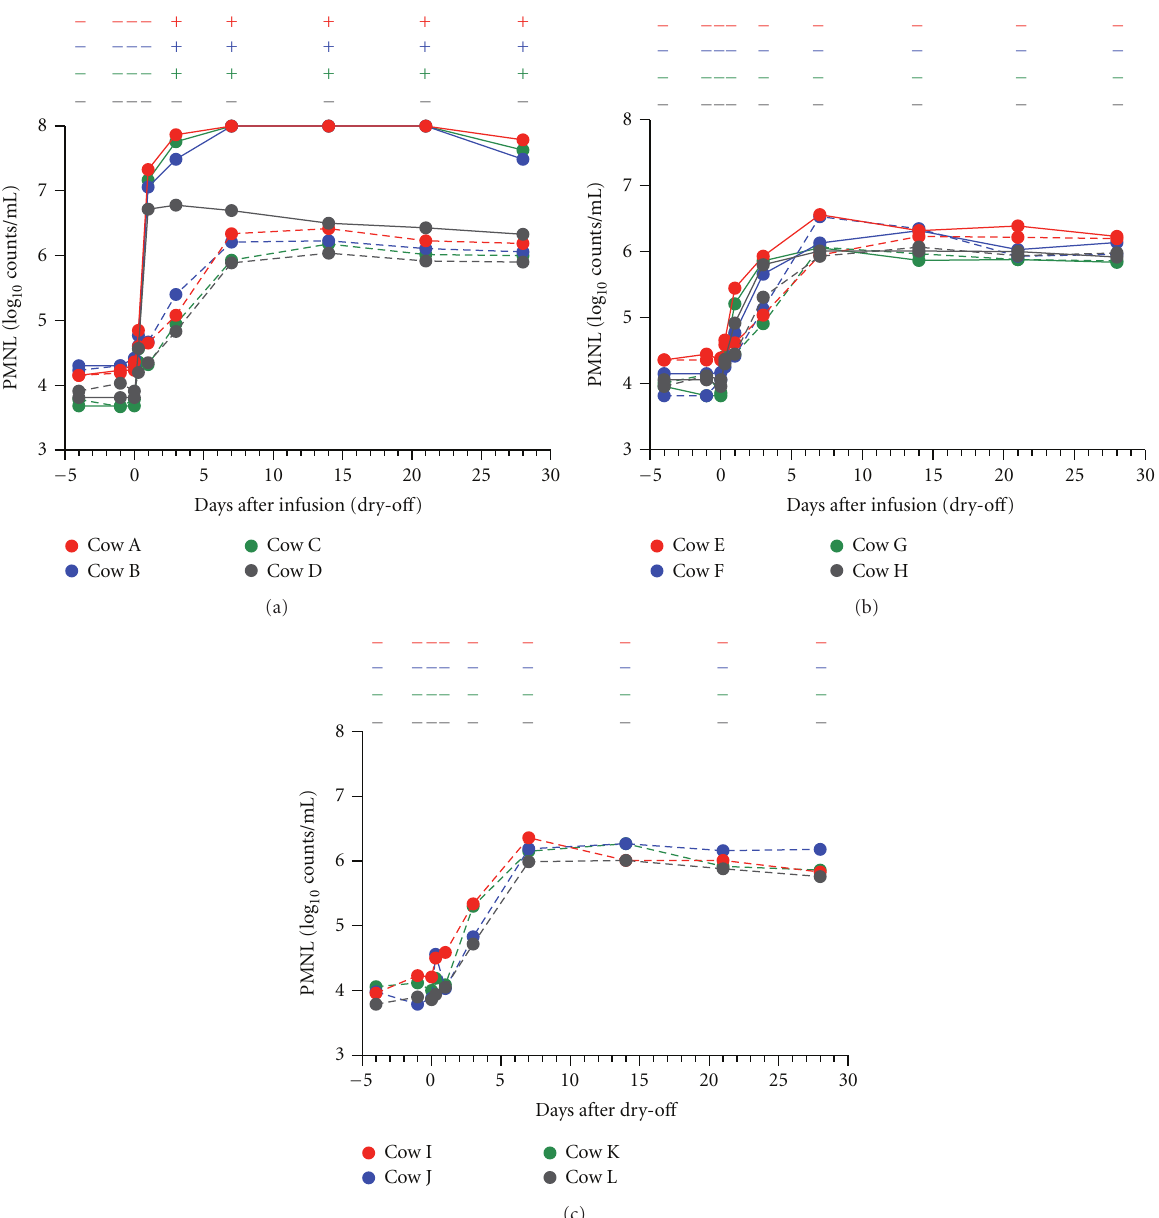
Figure 1: Polymorphonuclear leukocyte (PMNL) counts of the mammary secretions from rbIL-8-infused (solid line) and saline-infused (broken line) glands are shown in (a) and (b), respectively, and those of the mammary secretions obtained from the untreated glands during the drying-o ff period are shown in (c). Cows A–D and E–H were given 50 μ g and 10 μ g of rbIL-8, respectively. (+) or ( − ) in the upper part of each figure denotes the presence or absence of clots in the mammary secretions, respectively. As the PMNL counts were obtained after removing milk clots containing PMNL, the PMNL counts for the mammary secretions with milk clots were not accurate. PMNL counts of more than 10 8 cells/mL were not